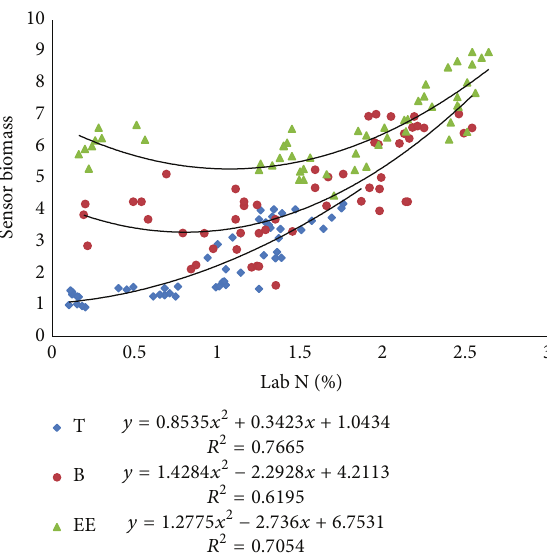
Figure 10: Correlations between sensor biomass and Lab N at different crop growth